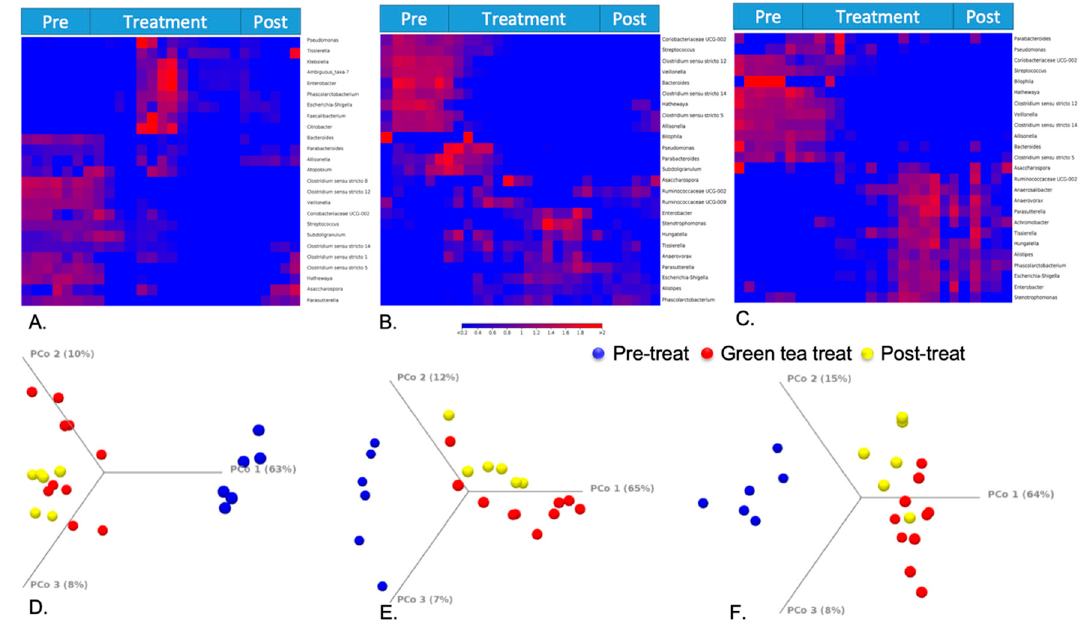
Figure 5. Heat map of taxonomical assignments of 3 parts of the HCM (( A ). Vessel 1; ( B ). Vessel 2; ( C ). Vessel 3). Beta diversity results by principal coordinate analysis (( D ). Vessel 1; ( E ). Vessel 2; ( F ). Vessel 3).